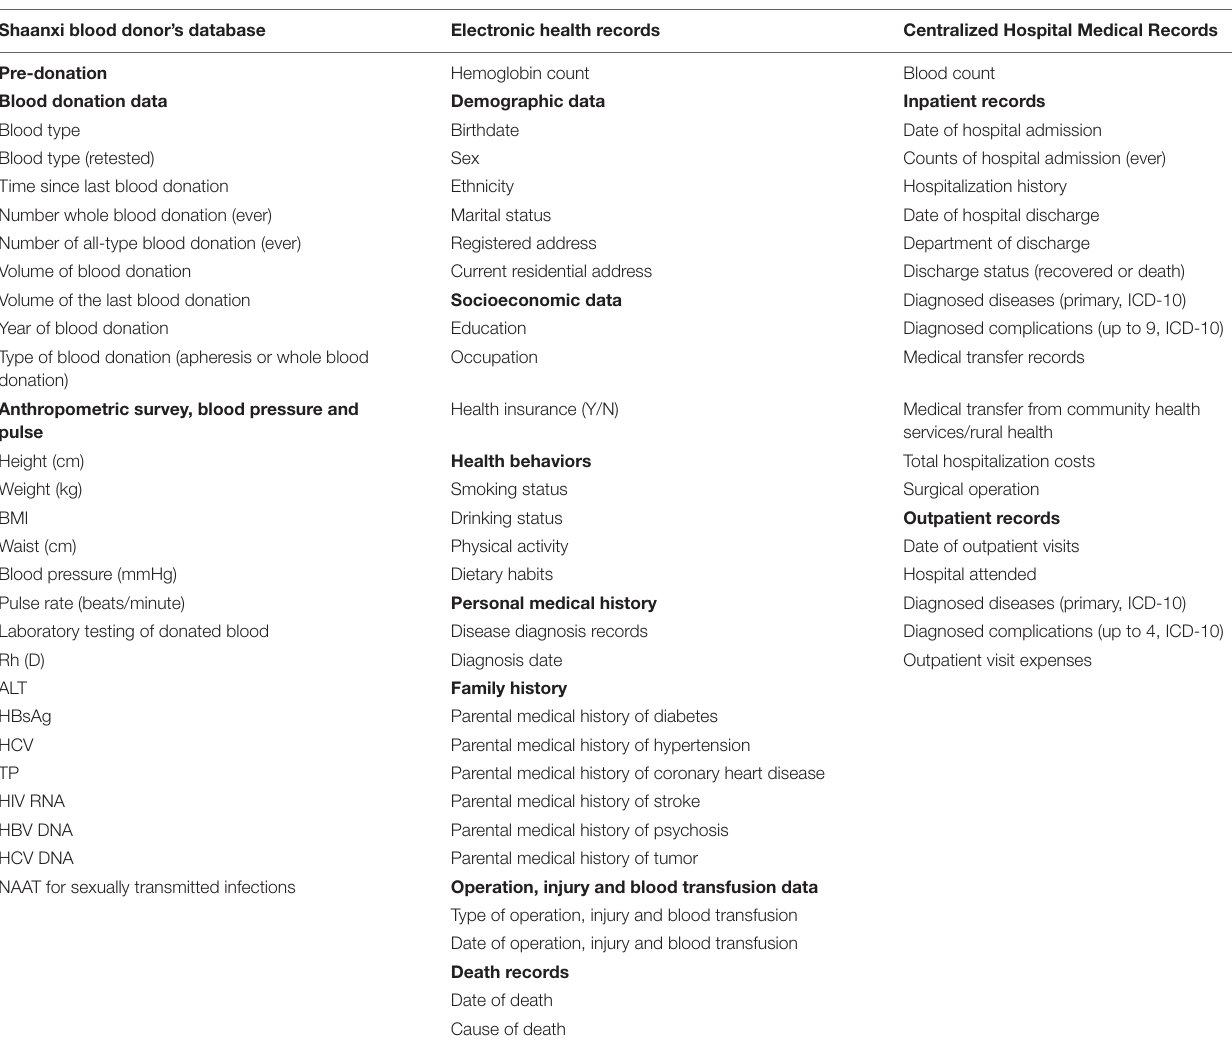
TABLE 1 | Summary of data collected in the Shaanxi Blood Donor Cohort, based on the linkage of three major health datasets. Shaanxi blood donor’s